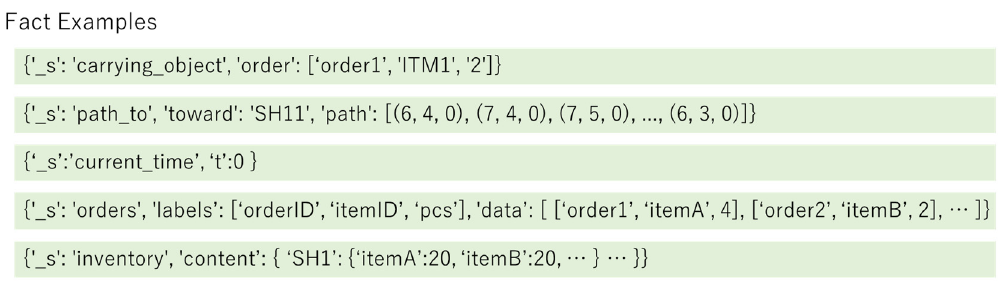
Figure 4. Fact architecture (example written in Python syntax).